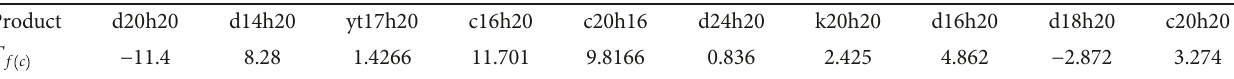
Table 4: T values for the 10 workpieces at the beginning of the warping stage. f c